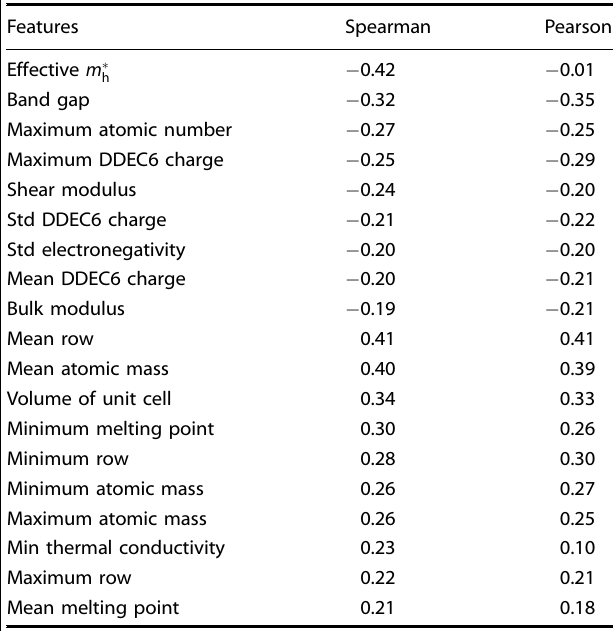
Table 3. Correlation analysis. Table 4. Feature